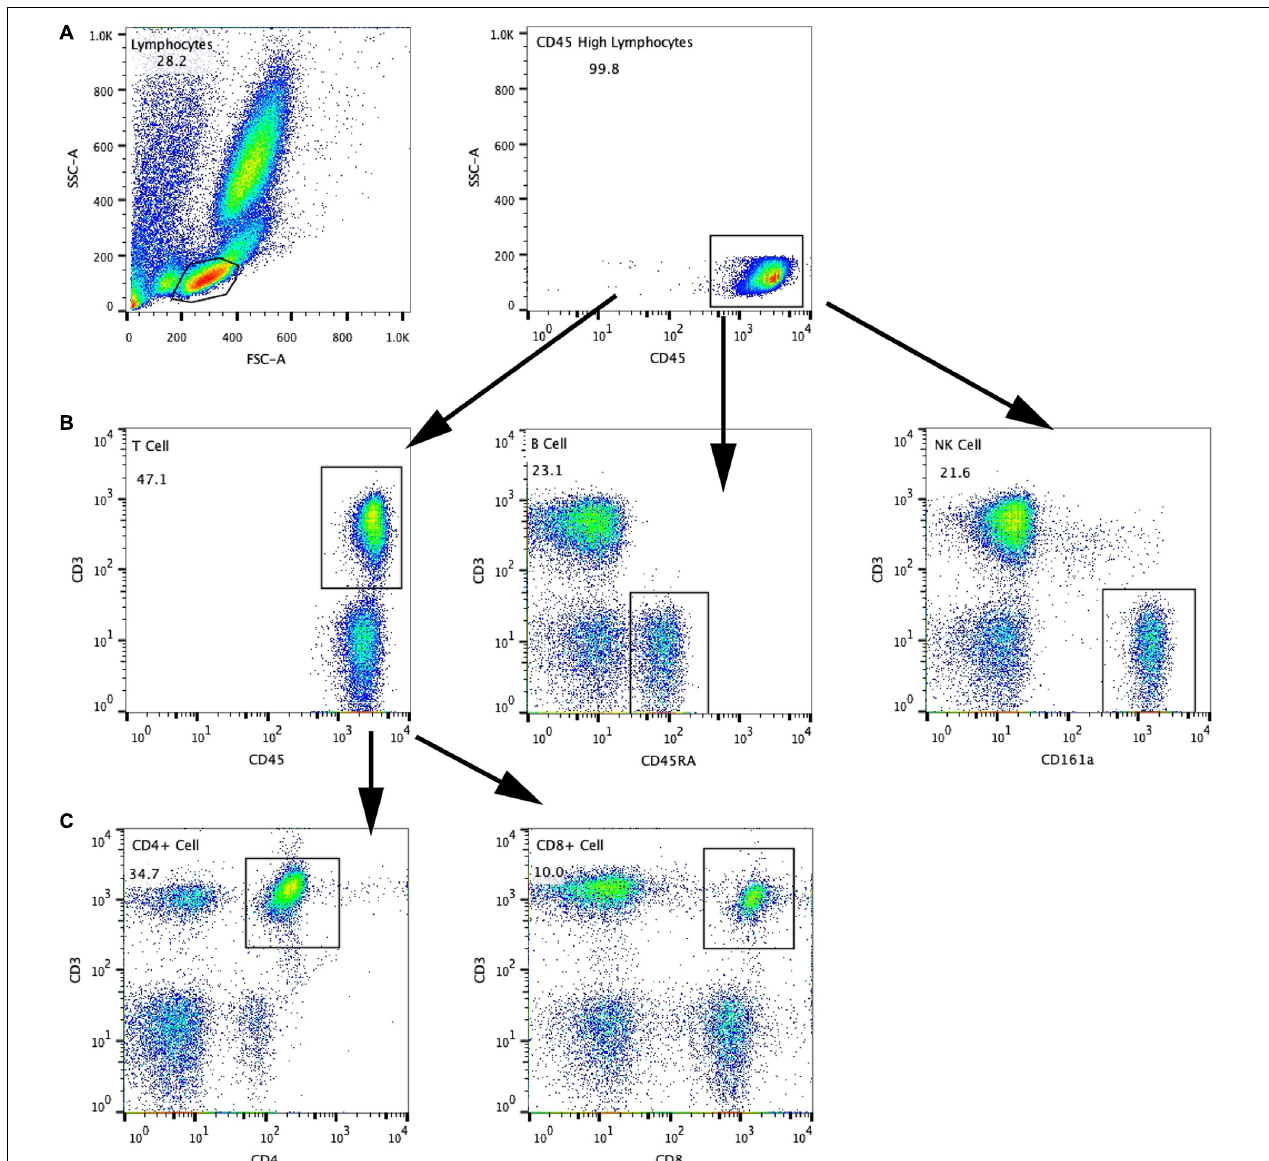
FIGURE 3 | The flow cytometry gating scheme for detecting each lymphocyte subgroup is shown in this figure. First of all, according to the physical properties of lymphocytes, the lymphocyte gate is set up according to the parameters of forward scatter and sideward scatter, and then, the lymphocyte gate (A) is further confirmed by SSC/CD45, second, to analyze the cells in the gate, the proportion of T cells (CD3 + cells) is determined by CD3/CD45, the proportion of B cells (CD3-CD45RA + cells) is determined by CD3/CD45RA, and the proportion of NK cells (CD3-CD161a + cells) is determined by CD3/CD161a (B) , and finally, the proportion of CD3 + CD4 + T cells (CD3 + CD4 + cells) was determined by CD3/CD4, and the proportion of CD3 + CD8 + T cells (CD3 + CD8 + cells) was determined by CD3/CD8 (C)